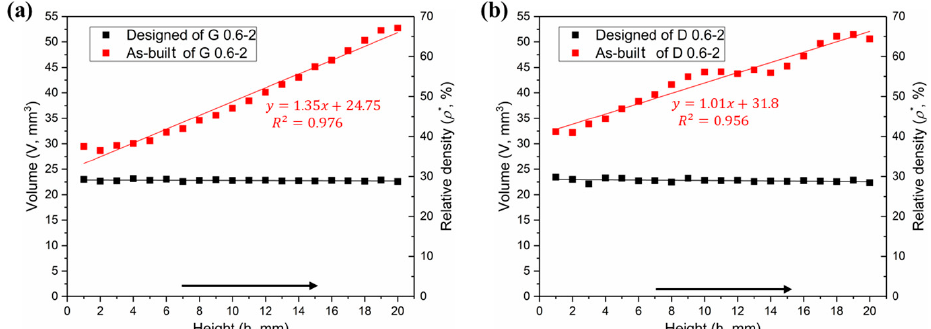
Figure 7. Comparative analysis of volume distributions between designed and as-built models, ( a ) Gyroid gradient porous structure, and ( b ) Diamond gradient porous structure.